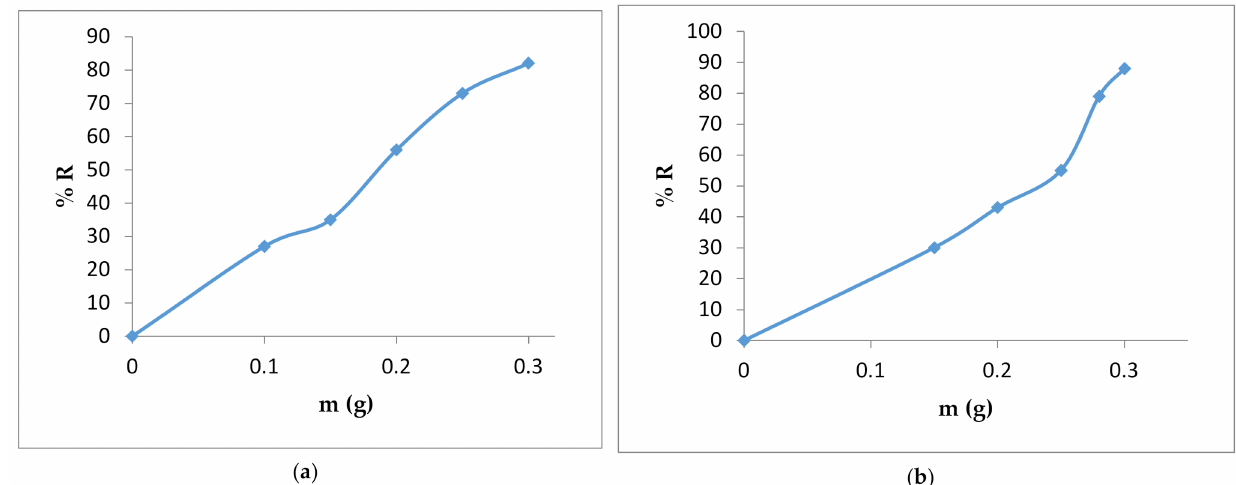
Figure 6. Effect of dosage on % removal of: ( a ) acid red 4 ( b ) methylene